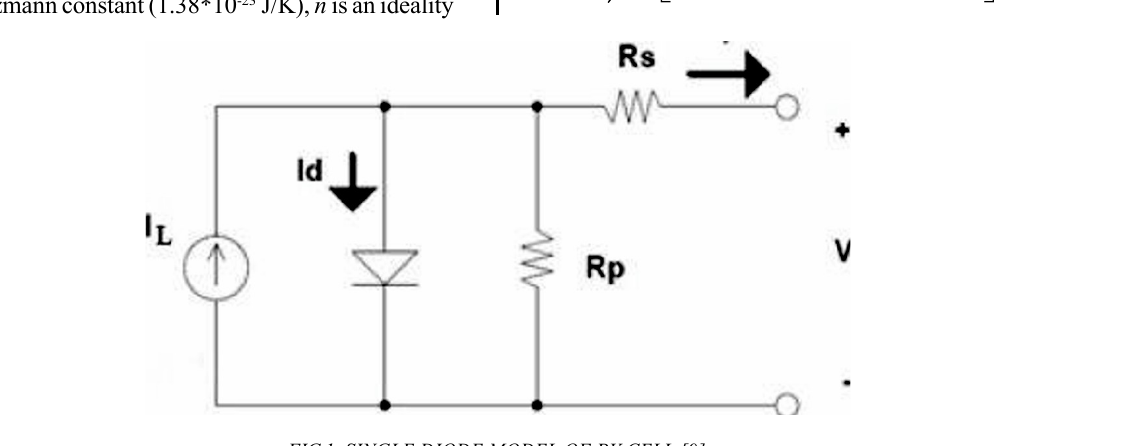
FIG.1. SINGLE DIODE MODEL OF PV CELL